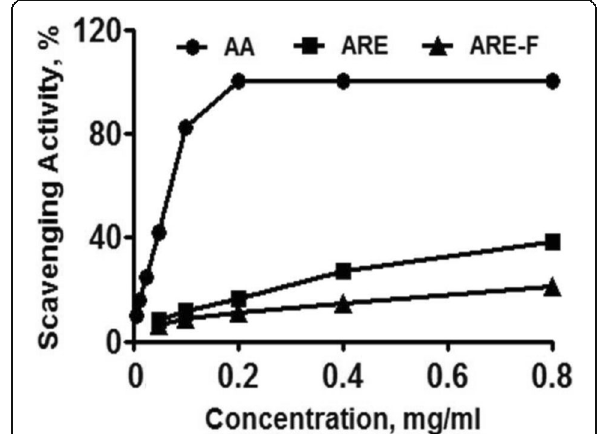
Fig. 6 The ABTS radical scavenging activities of ARE and ARE-F. AA was used as a positive control. Each value shows the mean ± SD of the three independent experiments repeated in